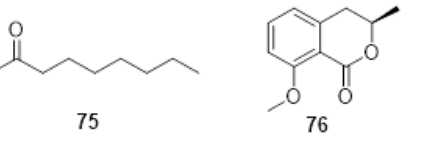
Figure 7. Structure of 2-nonanone ( 75 ), O-methylmellein ( 76 ).